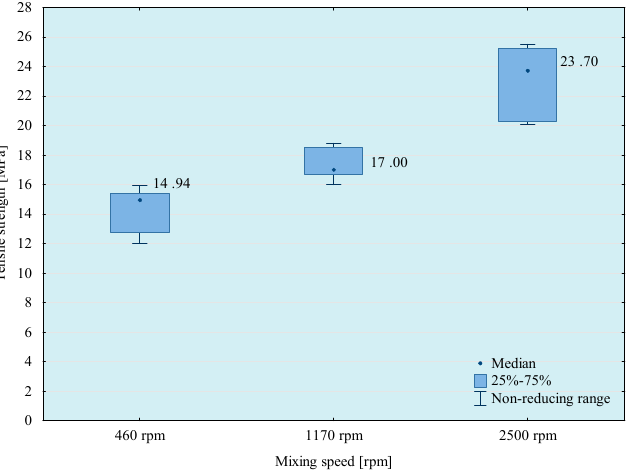
Figure 7. Tensile strength of E57/Z-1/100:10 composition as a function of mixing speed.